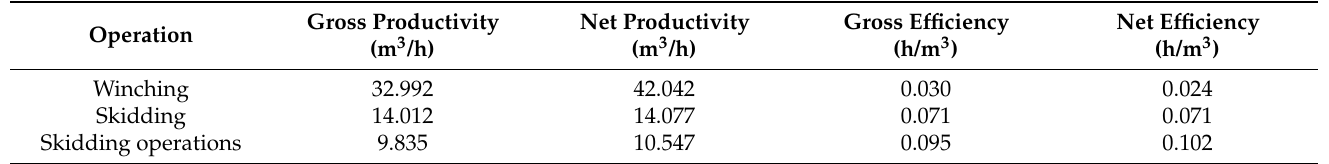
Table 6. Productivity and efficiency of operations in the observed conditions.